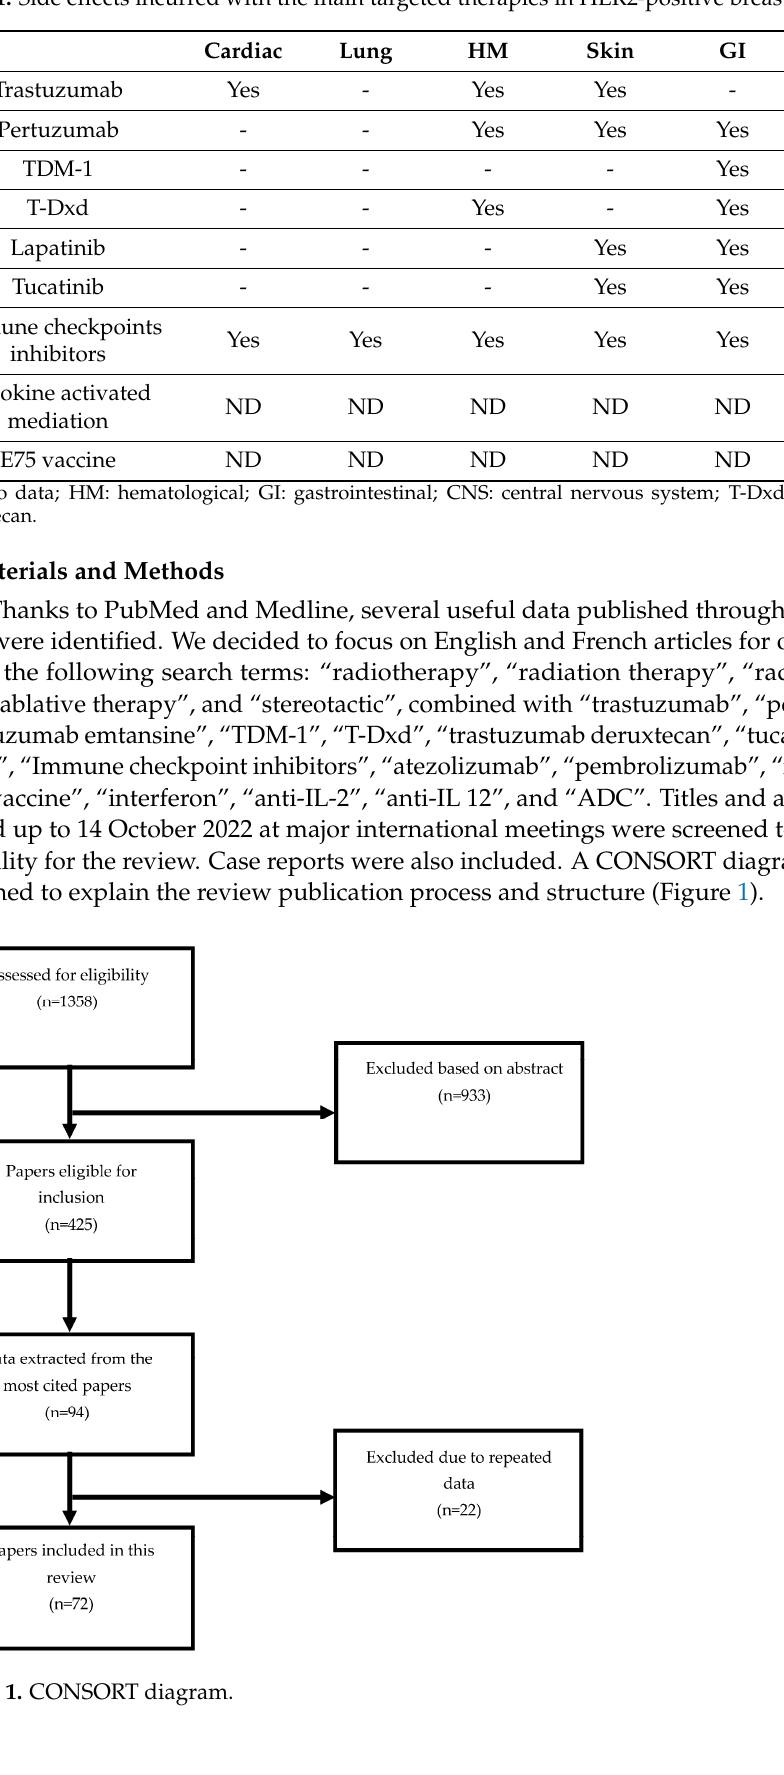
Table 1. Side effects incurred with the main targeted therapies in HER2-positive breast cancer.